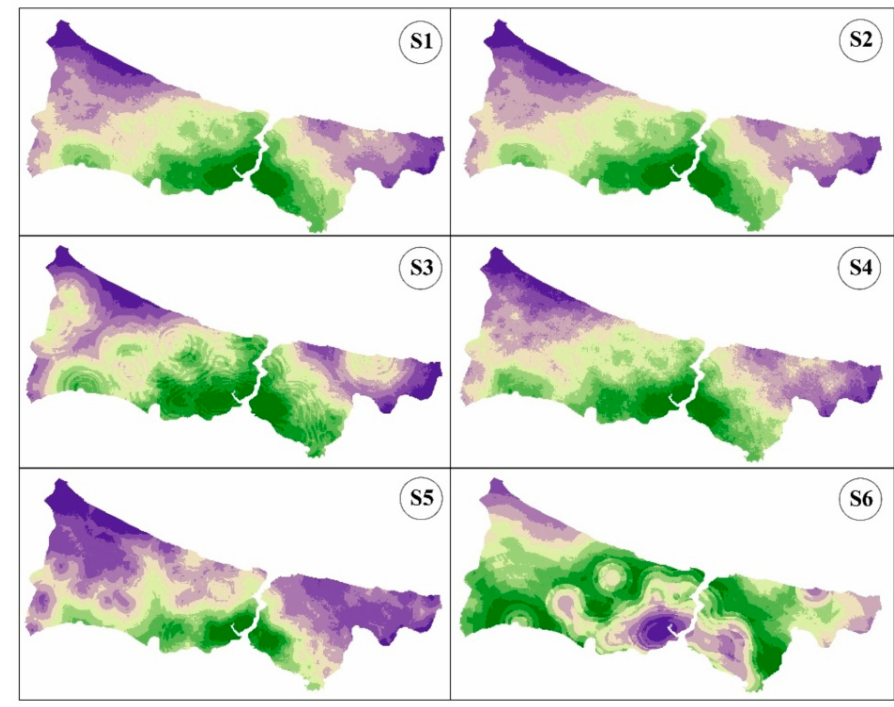
Figure 7. Suitability maps for changed criterion